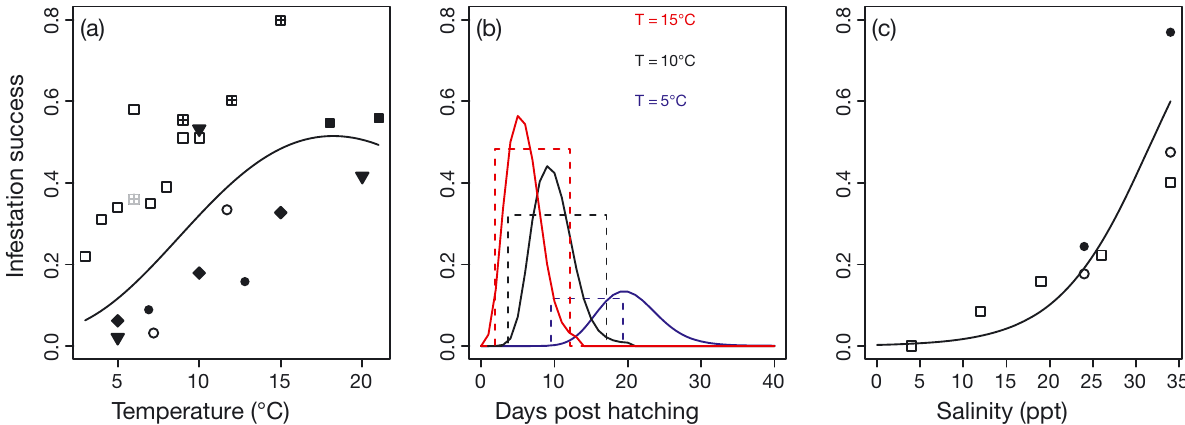
Fig. 5. Temperature- and salinity-dependent infestation success of salmon lice. (a) Points show infestation success as function of temperature in different experiments: S Expt 1 by Tucker et al. (2000), ● Expt 2 by Tucker et al. (2000), Z Samsing et al. (2016), r Skern-Mauritzen et al. (2020), H Expt 1 by Dalvin et al. (2020), batch 1 in Expt 2 by Dalvin et al. (2020, with the 6 degrees group shown in grey infected at 9 degrees and not used to fit the regression line), J batch 2 in Expt 2 by Dalvin et al. (2020). Line: regression line fitted by a mixed-effects model with a random effect of experiment (Eq. 13a). (b) Infection success as function of days post-hatching at 3 different temperatures. Unbroken lines: time-varying infectivity as estimated by Skern- Mauritzen et al. (2020, Eq. 13b). Broken lines: constant infectivity, with temperature effect on infection success according to Eq. (14a), larval development time according to Eq. (11b) and duration of infective stage according to Eq. (10). (c) Points show infestation success as function of salinity in different experiments: S Expt 3 by Tucker et al. (2000), ● Expt 4 by Tucker et al. (2000), H Bricknell et al. (2006). Line: regression line fitted by a mixed-effects model with a random effect of